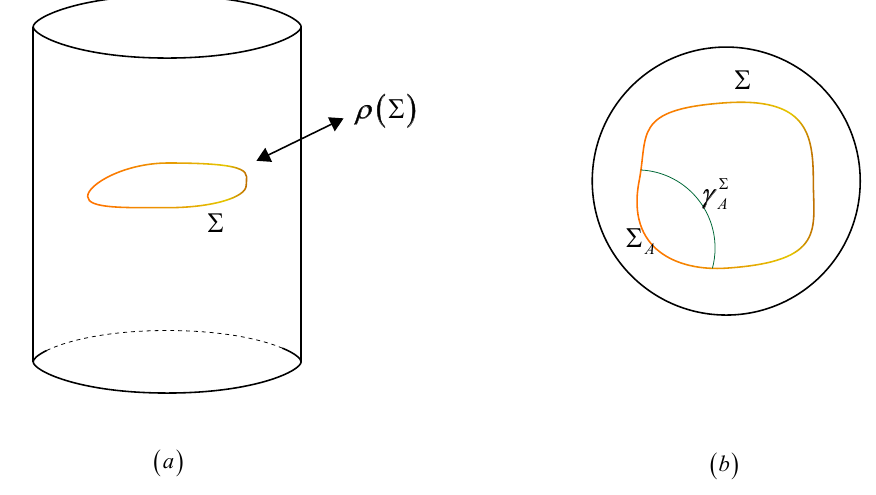
Figure 3 . (a) Surface/state correspondence. (b) Generalized RT